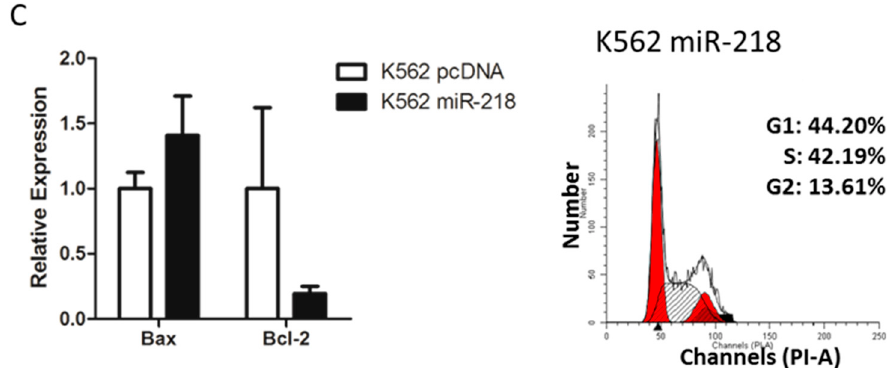
Figure 7. ( A ) Growth curve of control and K562 miR-218 cells. Cells were counted every two days. Asterisks indicate that differences between samples were statistically significant according to an independent-sample t -test, ** p < 0.01; ( B ) Cell-cycle assay of control and K562 miR-218 cells. Statistical percentages of each stage are shown; ( C ) Relative mRNA expression of BAX and Bcl-2 in control K562 cells and K562 cells overexpressing miR-218 using quantitative real-time PCR normalized to GAPDH .